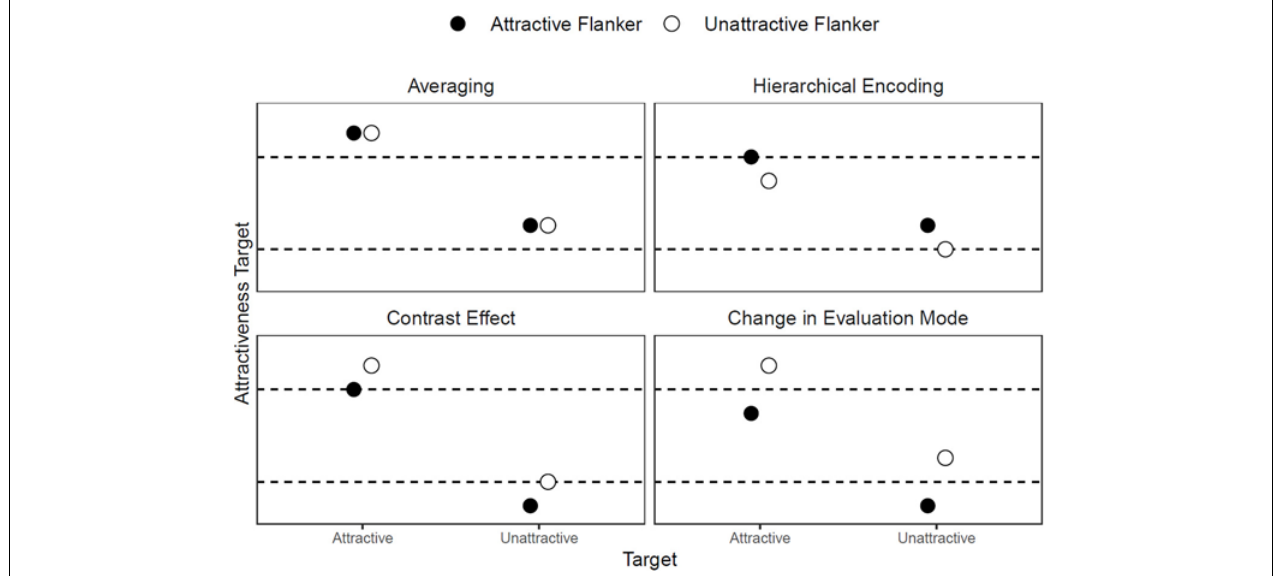
FIGURE 1 | Predictions of target face attractiveness. This figure illustrates that the four theories differ in their predictions of how the attractiveness of a target face changes when it is flanked by other faces. The dashed lines represent the ratings of the attractive and unattractive faces when they are not flanked. The circles indicate the ratings of the flanked faces. Averaging visual information leads to increased perceived attractiveness, regardless of the attractiveness of the target and flankers compared to the unflanked target. According to hierarchical encoding, visual information is stored in higher-order representations. The rating of the target depends on this representation and drifts to the mean rating of all simultaneously presented faces. The contrast effect states that the flanking faces provide the standard of comparison for the target faces. If this standard is low, the target is rated as more attractive and vice versa. Presenting a target with flankers rather than in isolation leads to a change in the evaluation mode. The target is no longer compared to the internal standard; instead the difference between target and flankers becomes important. If there is a contrast between target and flankers, the rating becomes more extreme; if there is no contrast, the rating becomes more moderate. This figure demonstrates that the four theories differ in their predictions of how the attractiveness of a target face changes when it is flanked by other faces.